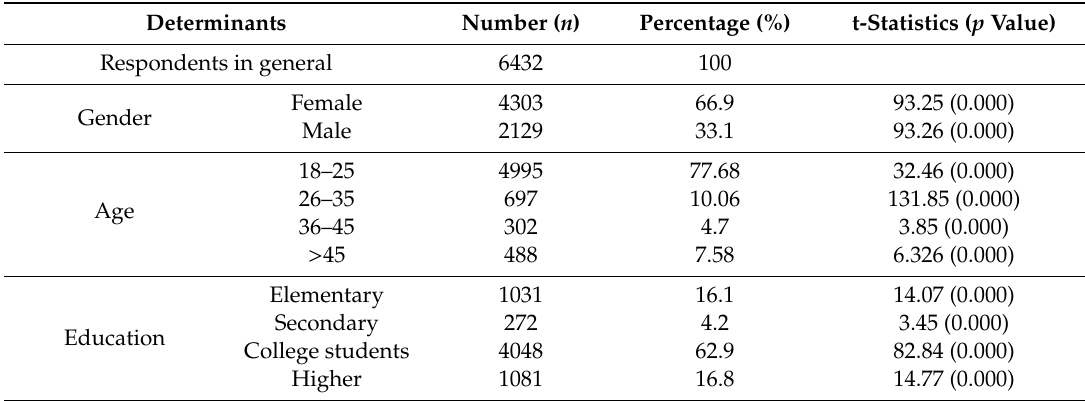
Table 2. Study group